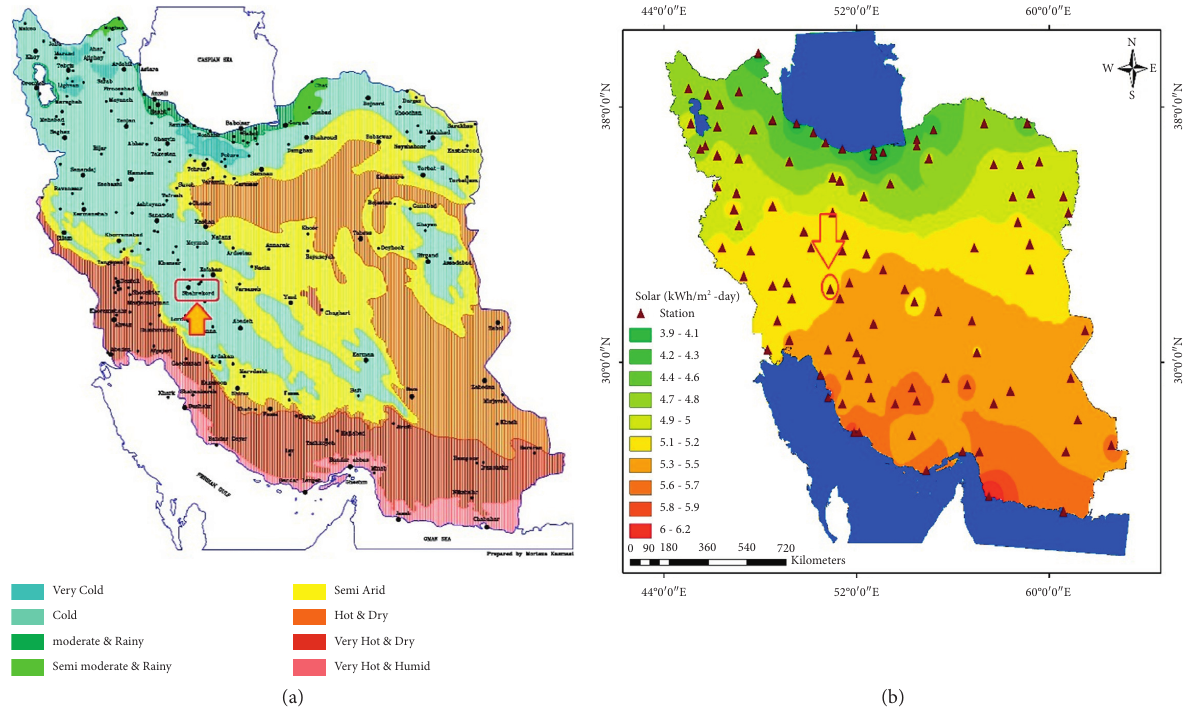
Figure 4: Location of Shahrekord on (a) climatic map of Iran [34] and (b) radiation map of Iran [35].